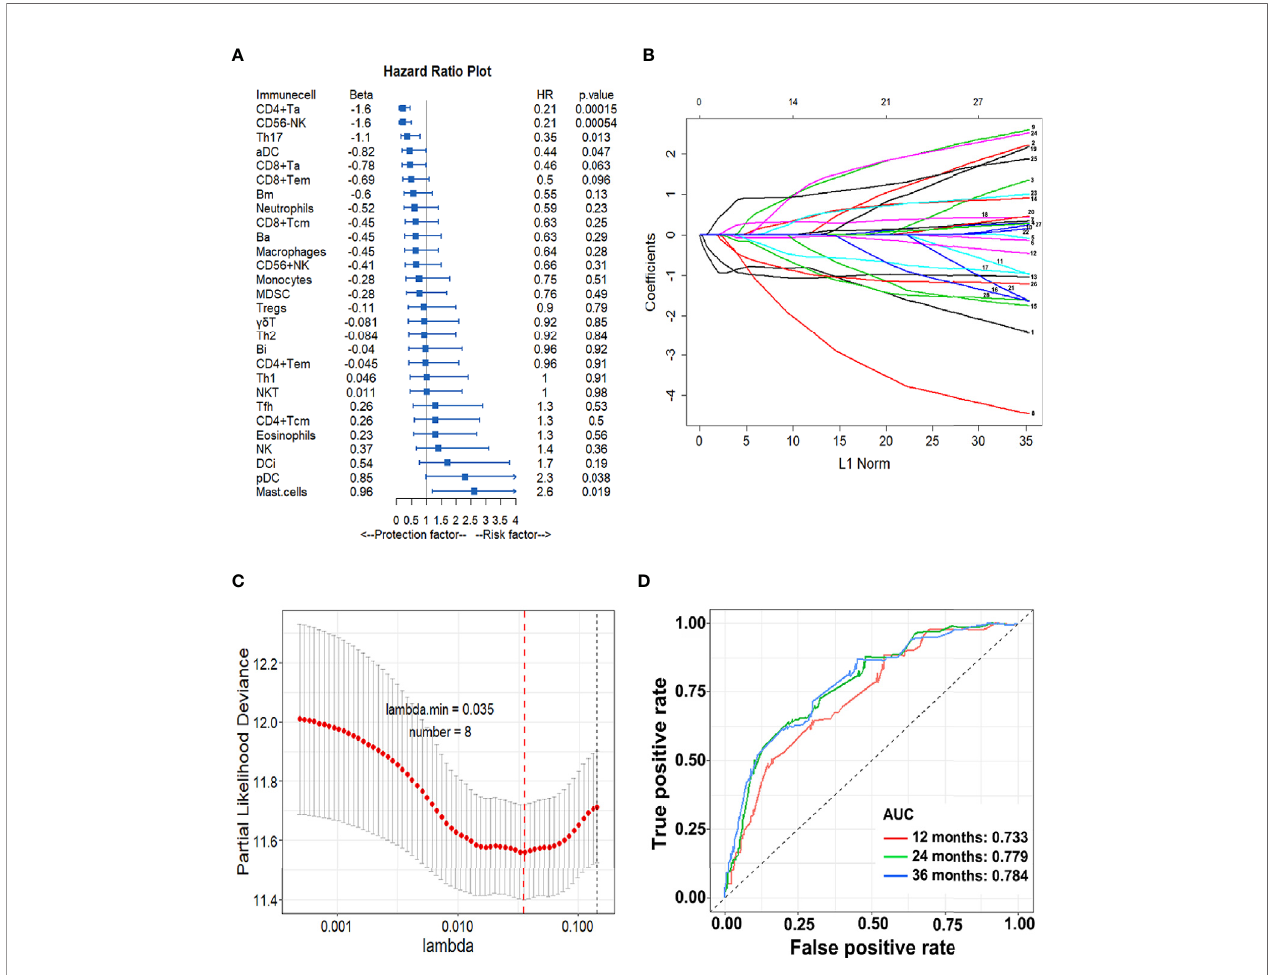
FIGURE 2 | Construction of the IS model. (A) Forest plots of HRs for tumor in fi ltrating cells by univariate Cox analysis; (B) LASSO coef fi cient pro fi les of the 28 immune cell fractions; Immune cell types: 1.CD4 + Ta; 2.CD8 + Ta; 3.aDC; 4.CD56 + NK; 5.CD4 + Tcm; 6.CD8 + Tem; 7. CD4 + Tem; 8.CD8 + Tcm; 9.NK; 10.NKT; 11.Th1; 12.Th17; 13.CD56 − NK; 14.DCi; 15. Macrophages; 16.MDSC; 17.Neutrophils; 18.pDC; 19.Tregs; 20.Th2; 21.Ba; 22.Eosinophils; 23. gd T; 24.Bi; 25.Mast cells; 26.Bm; 27.Monocytes; 28.Tfh; (C) Ten-fold cross-validation for tuning parameter selection in the LASSO model. Error bars represent con fi dence intervals for partial likelihood deviance as L was changed. The dotted line indicates the optimal values; (D) The IS measured by time-dependent ROC curves in the training cohort. The area under the ROC curve is de fi ned as AUC. HR , hazard ratio; LASSO , least absolute shrinkage and selection operator; ROC , receiver-operating characteristic.